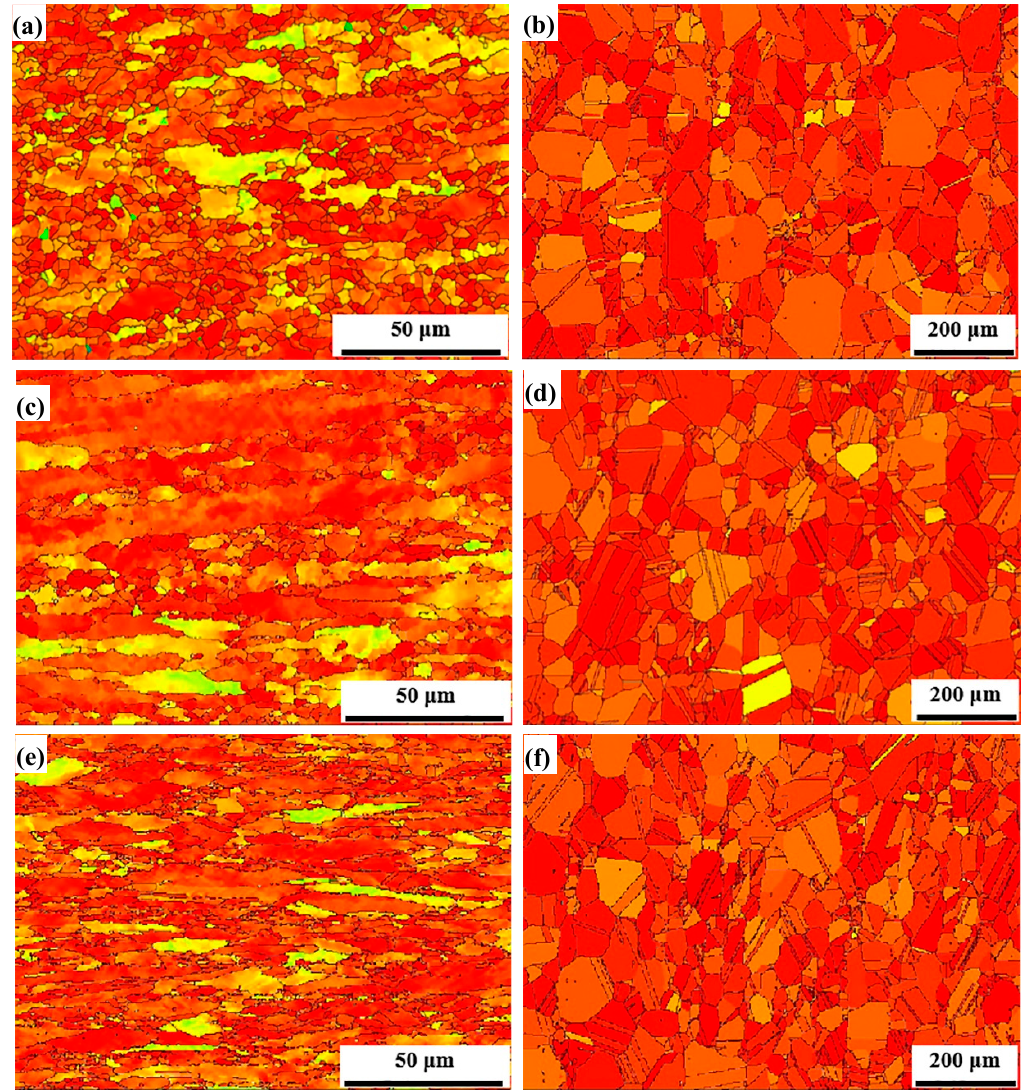
Figure 9. Schmid factor distributions of the AFA steel. ( a ), ( c ), ( e ) represent cold-rolled samples with reductions of 5%, 10%, 30%, and ( b ), ( d ), ( f ) represent the corresponding annealed samples after cold rolling. Materials 2020 , 13 , x FOR PEER REVIEW